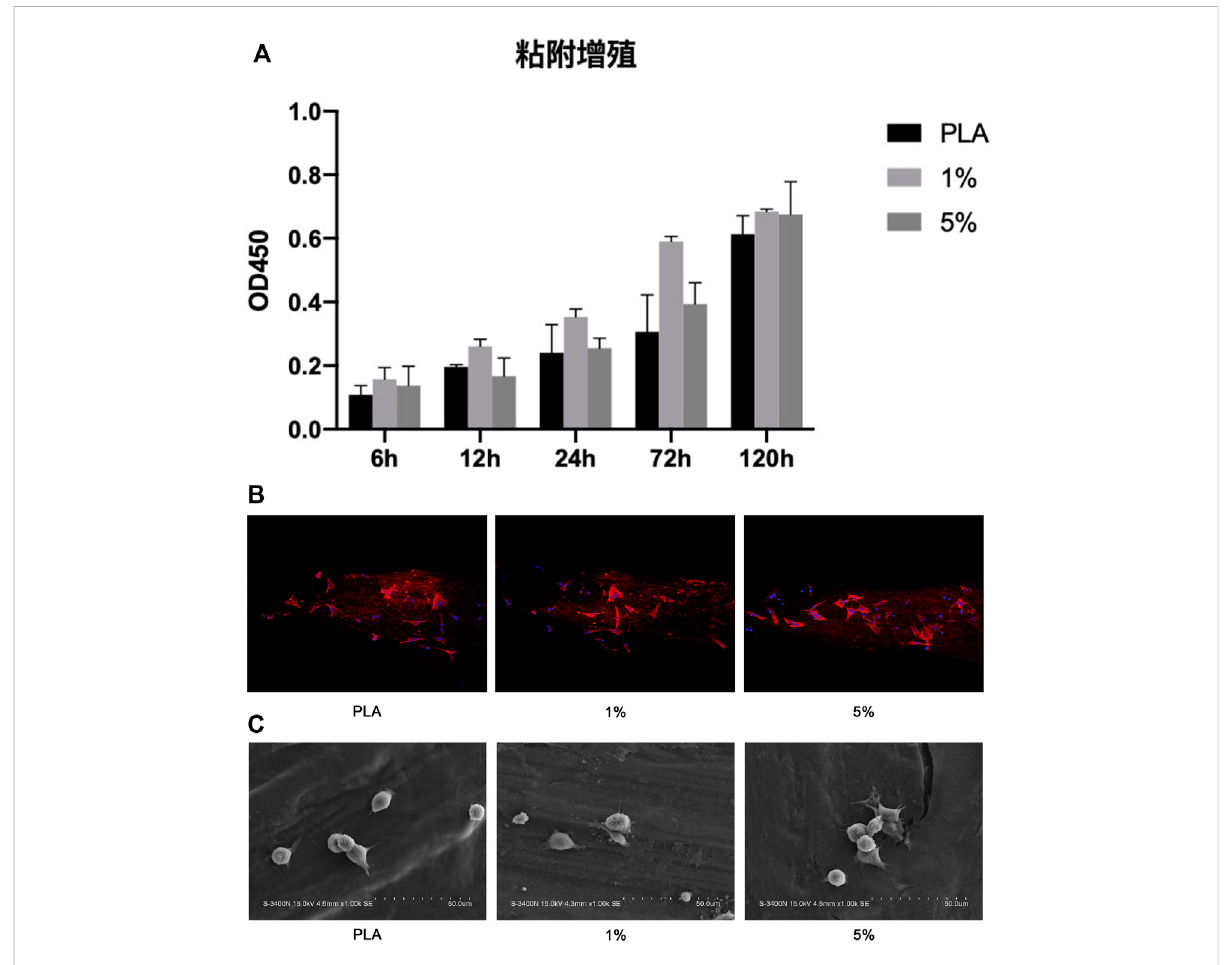
FIGURE 6 CocultureofBMSCswithscaffolds. (A) CCK-8experiment; (B) 3DCLSMpicturesofcellsonscaffolds(24 h); (C) SEMimagesofcellsadheredon scaffolds (12